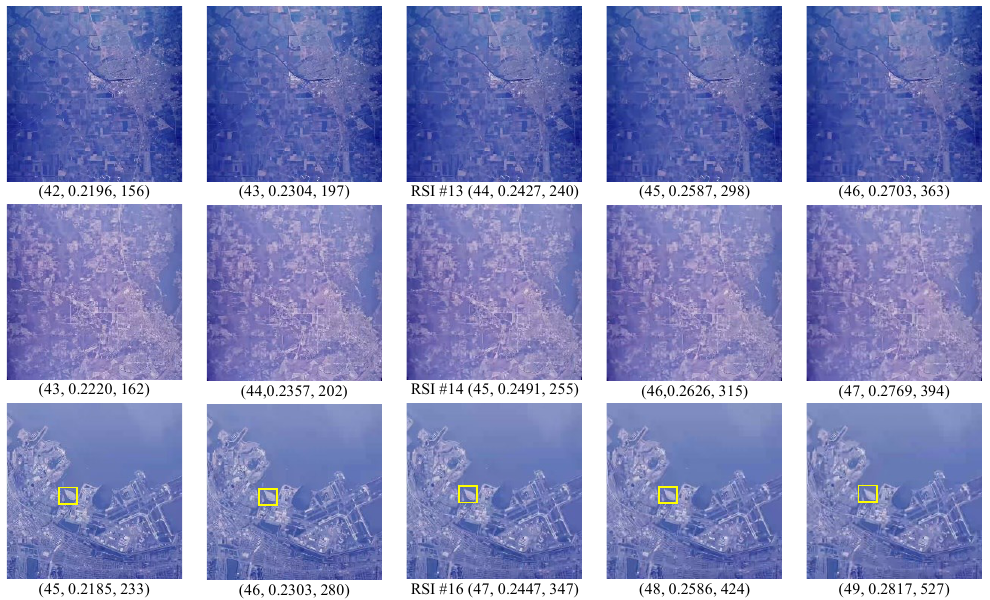
Figure 9. The sample decompressed images obtained for the Q values around Q des . The values provided in brackets concern Q , MDSI, and CR values,